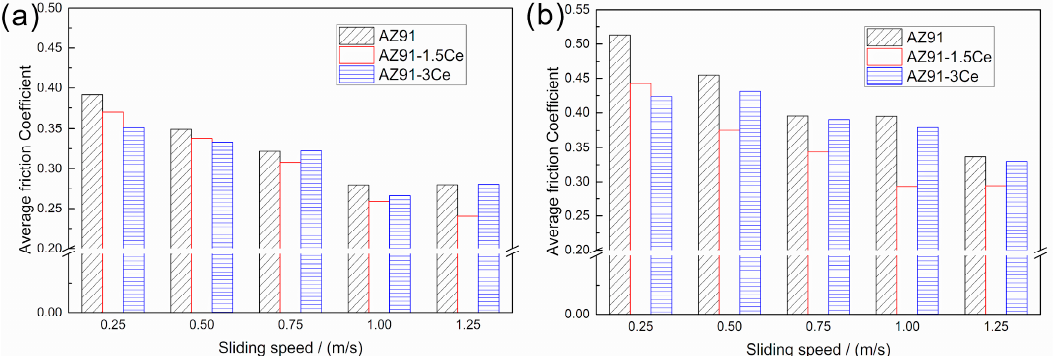
Figure 5. Average friction coefficient for ( a ) 10 N, ( b ) 20 N loads.